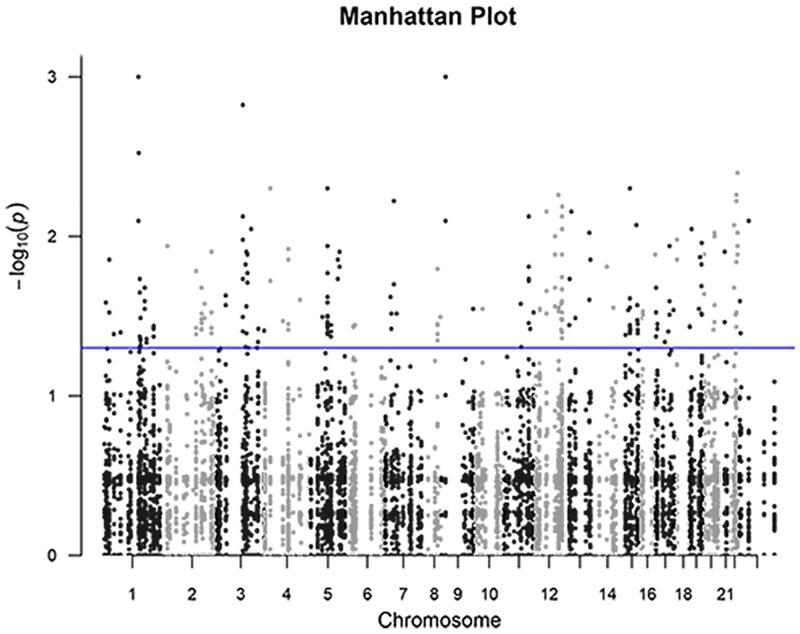
Manhattan Plot of Significant Variants.The 13,000 variants from the targeted exome library and 11,000 variants from the haplotype block library were compared for difference in abundance in the cases versus the controls. The figure shows a Manhattan plot of all variants across 22 autosomes with the vertical axis being the -logP value from the statistical test for association, with the threshold line (-logP 1.3) indicating p-value of 0.05. There were 205 and 168 variants that significantly differed in abundance in cases versus controls from the exome and haplotype block libraries respectively.